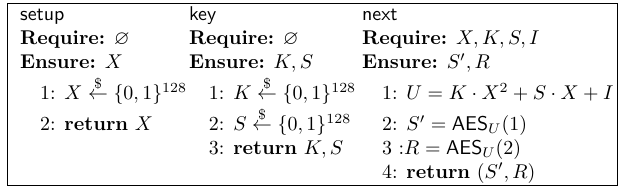
Figure 11: CIA , CSA , KKA : A Secure